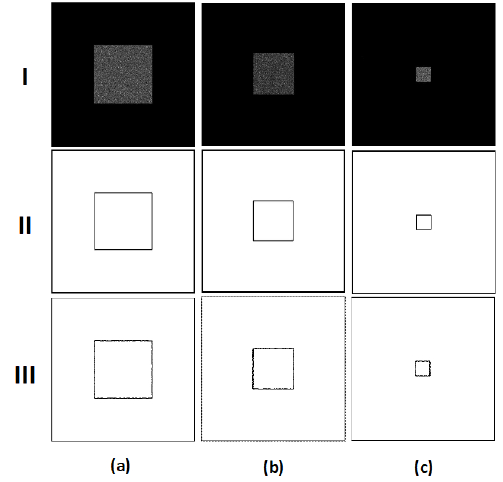
Figure 1. Synthetic images examples: (I) Noisy images, (II) GT (Ground Truth), (III) Adaptive Canny result. Images with objects of size (a) 200, (b) 150 and (c) 50.